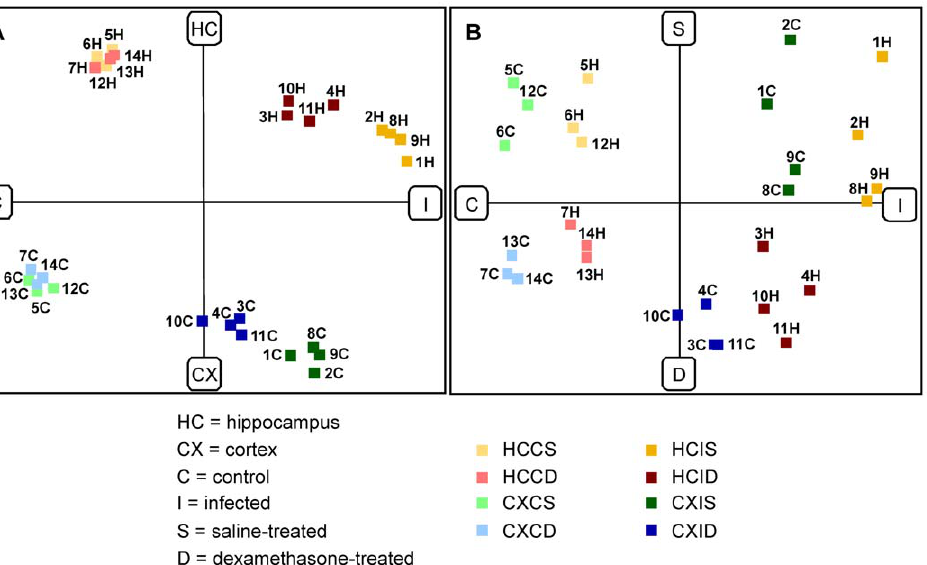
Figure 4. The correspondence analysis (COA) of the microarray dataset. The COA separated in component one (x axis in A and B) the control from the infected animals, in component two (y axis in A) the hippocampus from the cortex samples and in component three (y axis in B) the dexamethasone treated from the saline treated animals. Each square represents an array. H=hippocampus, C=cortex. Equal numbers in the hippocampus and cortex group indicates that these samples derived from the same animal.